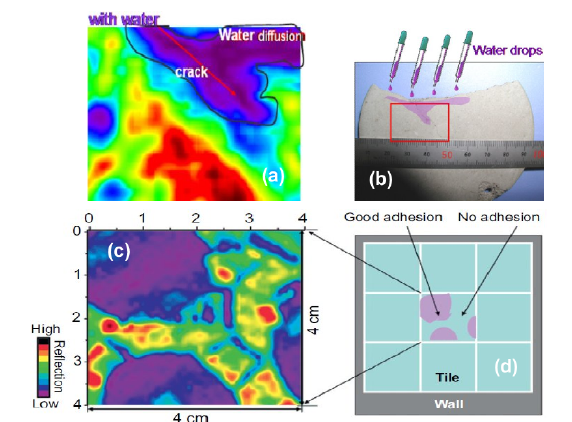
Figure 5. ( a ) Terahertz imaging of cracks in concrete, in which water diffuses along the cracks which enhances the detection sensitivity of the defect. ( b ) Is an illustration that depicts the process of water percolation which increases the contrast around the crack. ( c ) Is a terahertz image of the voids of the adhesive cement under a tile. ( d ) illustrates the geometry of the measurement shown in ( c ) [40]. Adapted with permission from [NDT & E International], Elsevier,